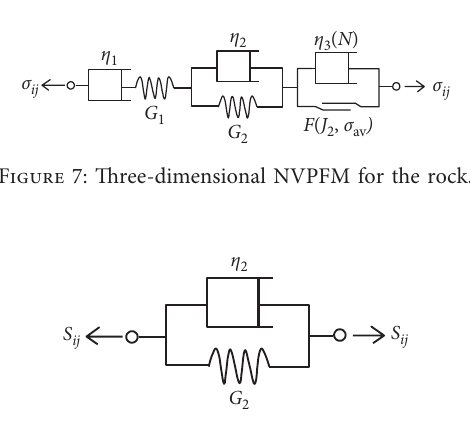
Figure 9: Three-dimensional nonlinear viscoplastic fatigue